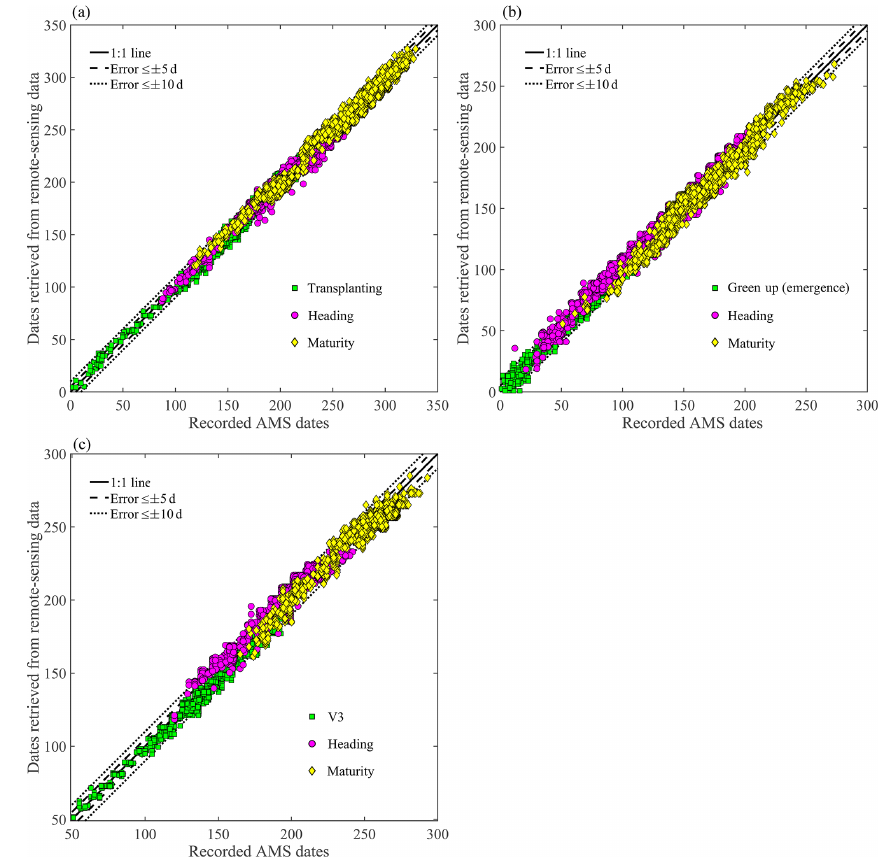
Figure 5. Comparisons between retrieved and observed phenological dates for rice (a) , wheat (b) and maize (c) .